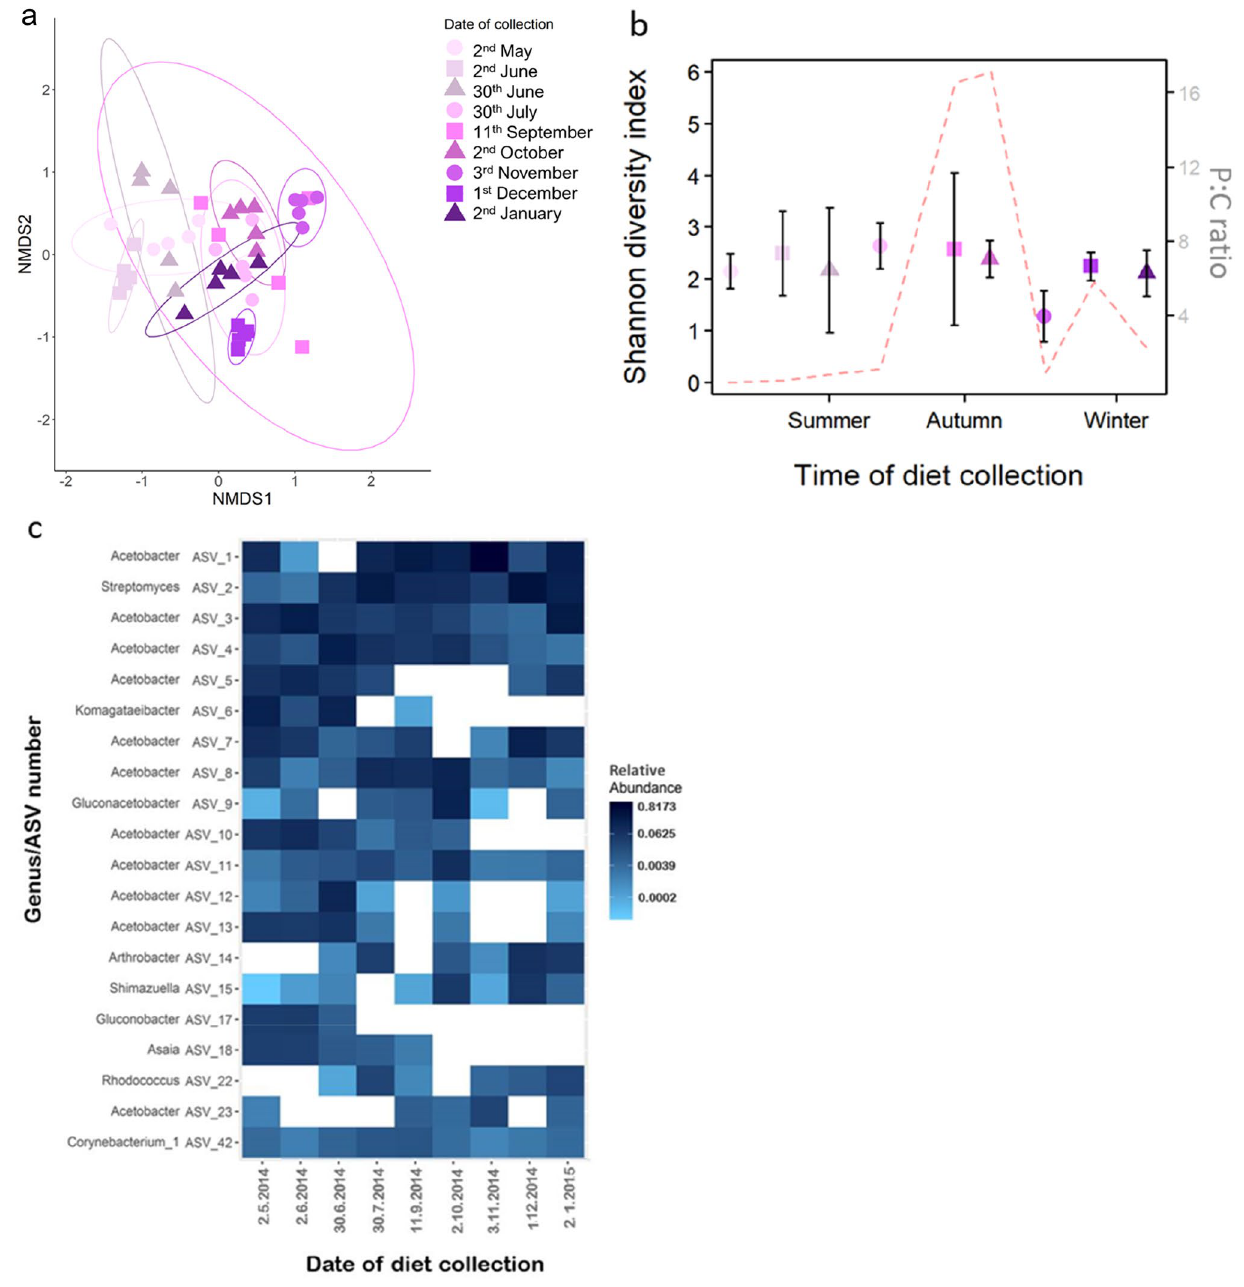
Figure 2. Microbial community structure of the flies developed on the different diets ( n = 4–5). ( a ) Two- dimensional nonmetric multidimensional scaling (NMDS) axes based on Bray–Curtis dissimilarity matrices of amplicon sequence variants (ASVs). Each point represents the microbial community in a sample. Flies were grouped in 5 to represent one sample. ( b ) Shannon diversity index (left y-axis) of the microbial community of the fly samples across the food collection days. Points show mean (± 95% CI). Smaller points represent replicates. Colour and symbol code same as ( a ). The red dotted line represents the protein to carbohydrate (P:C) ratio of the diet (right y-axis). ( c ) The 20 relatively most abundant ASVs across fly samples with relative abundance indicated by the colour coding. Figures ( a,b ) created using R package ggplot2 v3.3.3 (https:// ggplo t2. tidyv erse. org/). Figure ( b ) created using R package phyloseq v1.34.0 (https:// github. com/ joey7 11/ phylo